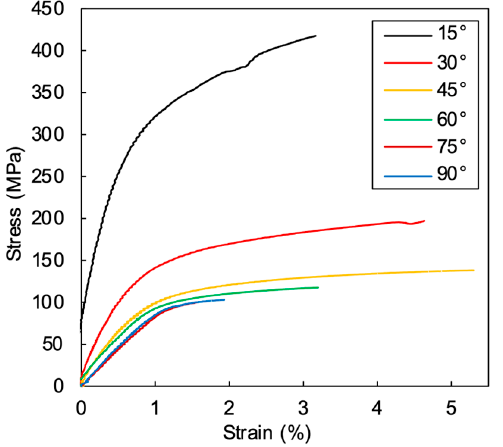
Figure 6. Stress-strain relationships of different off-axis tension tests. The off-axis tension stiffness vs. off-axis angle relationship is shown in Figure 7a.